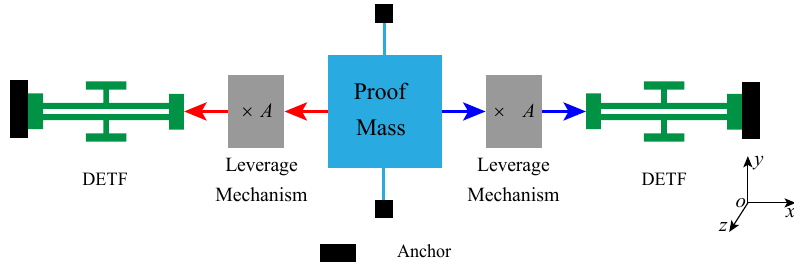
Figure 3. Structural diagram of the MEMS silicon resonant